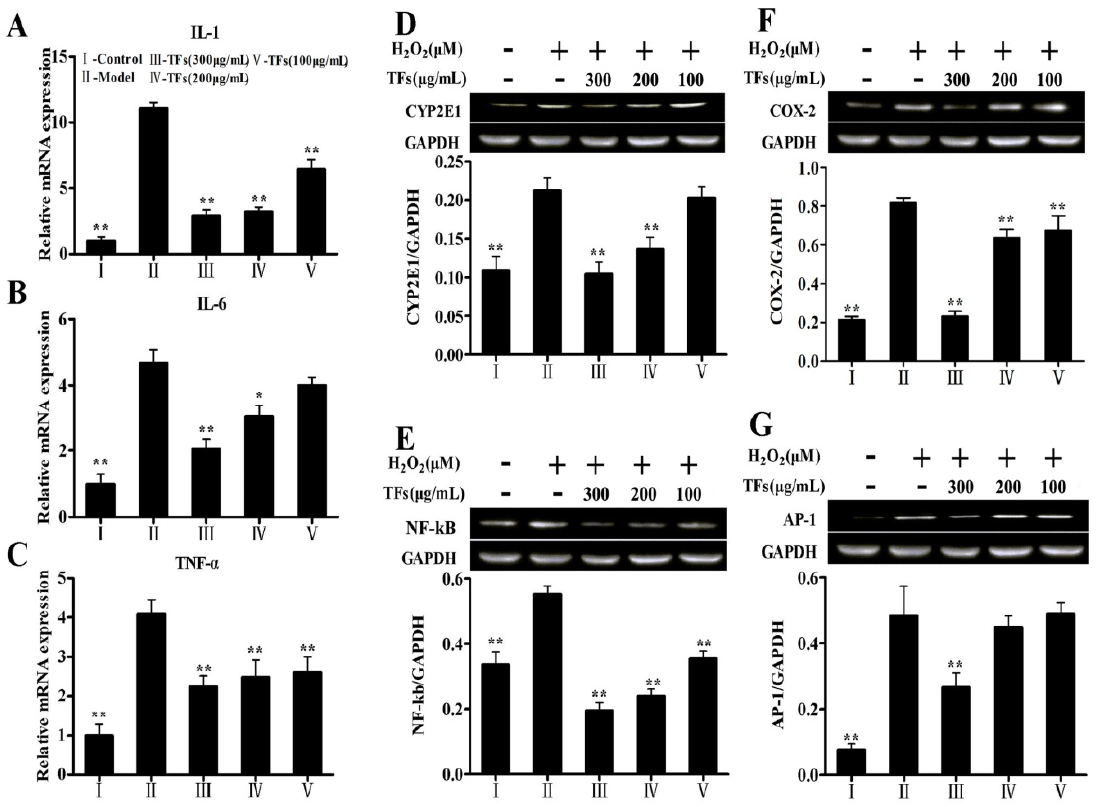
Figure 5. Effects of the TFs on the gene expressions of IL-1 ( A ), IL-6 ( B ), TNF-α ( C ), and protein expressions of CYP2E1 ( D ), NF-kb ( E ), COX-2 ( F ), and AP-1 ( G ). Values are expressed as mean ± SD ( n = 5). * p < 0.05 and ** p < 0.01 compared with model